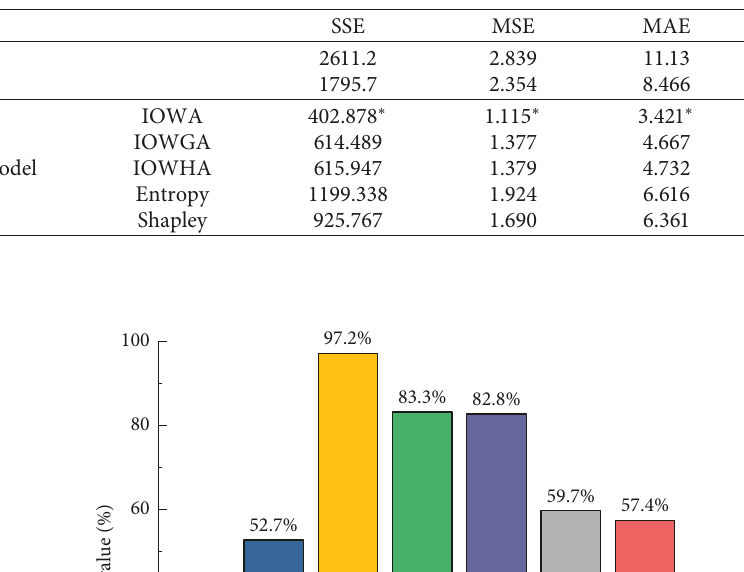
Table 5: Evaluation indexes of the forecasting effect.